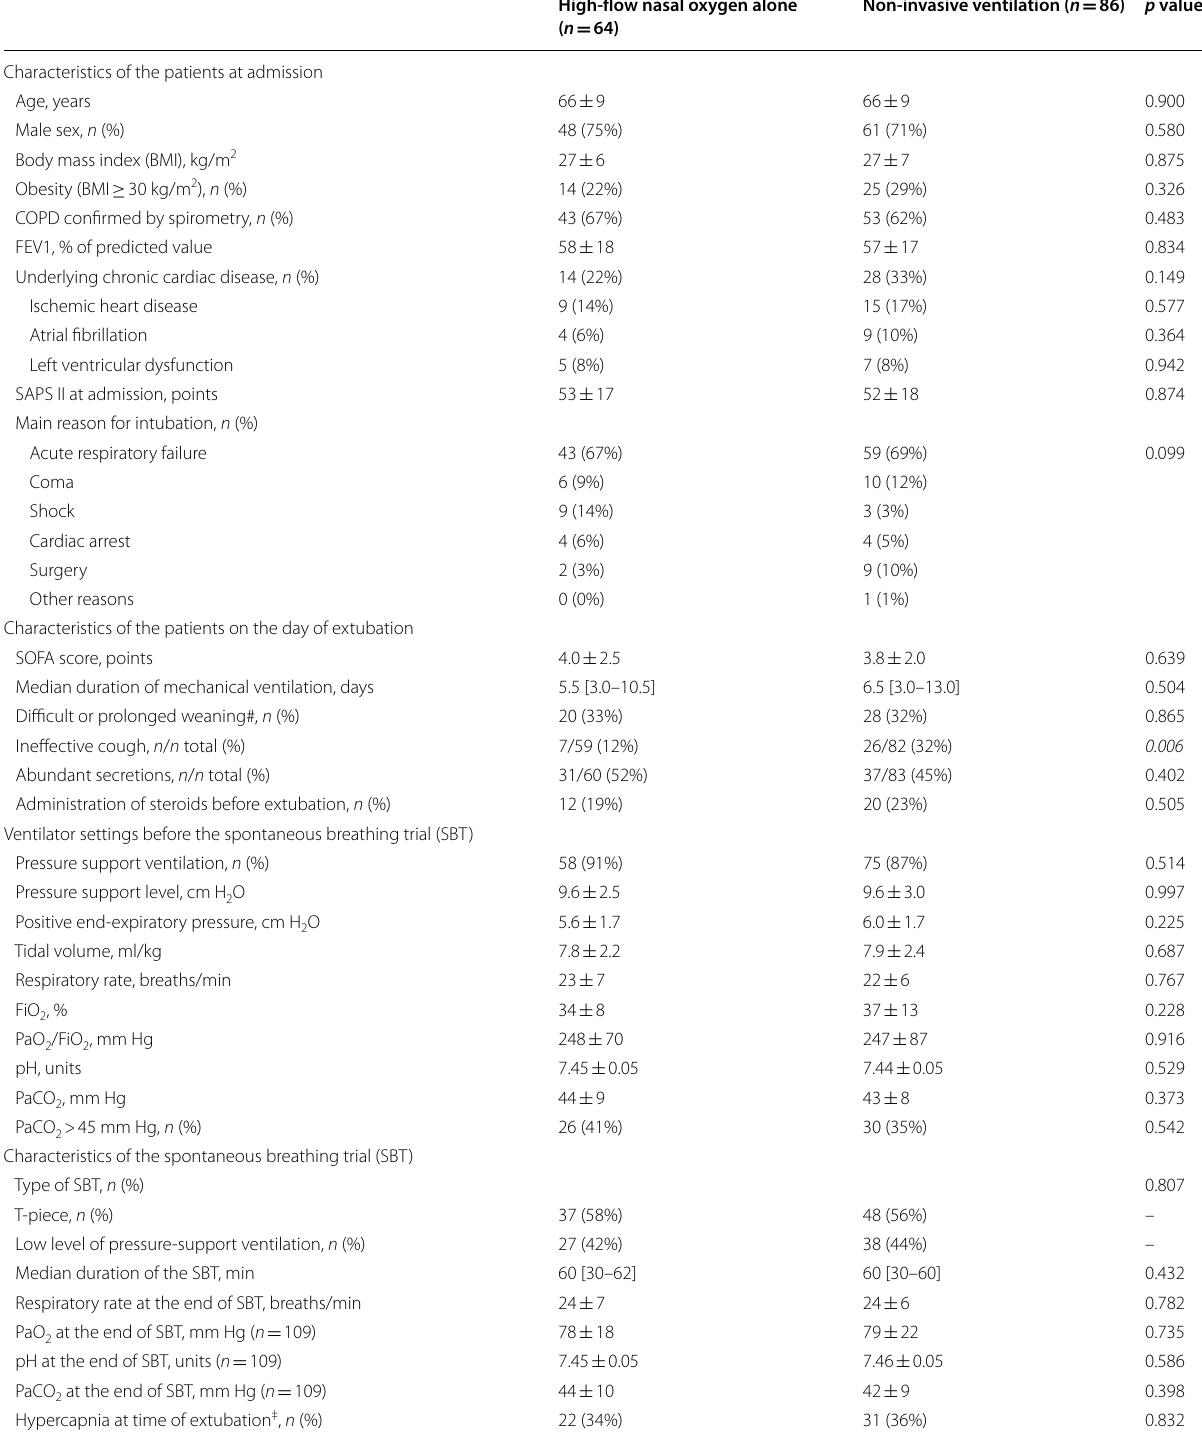
Table 1 Baseline patient characteristics according to the oxygenation strategy used after